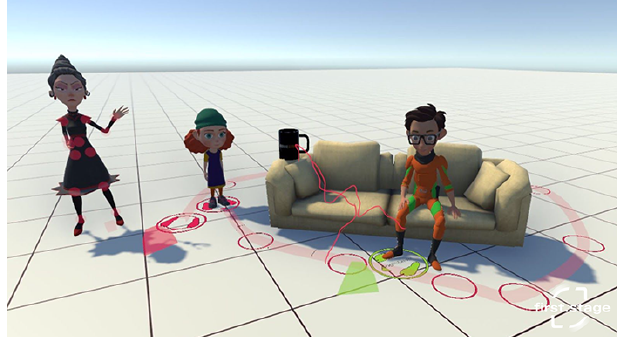
Figure 21. Rigid animation of a mug which can be manipulated by grabbing it at points and moving it as desired.